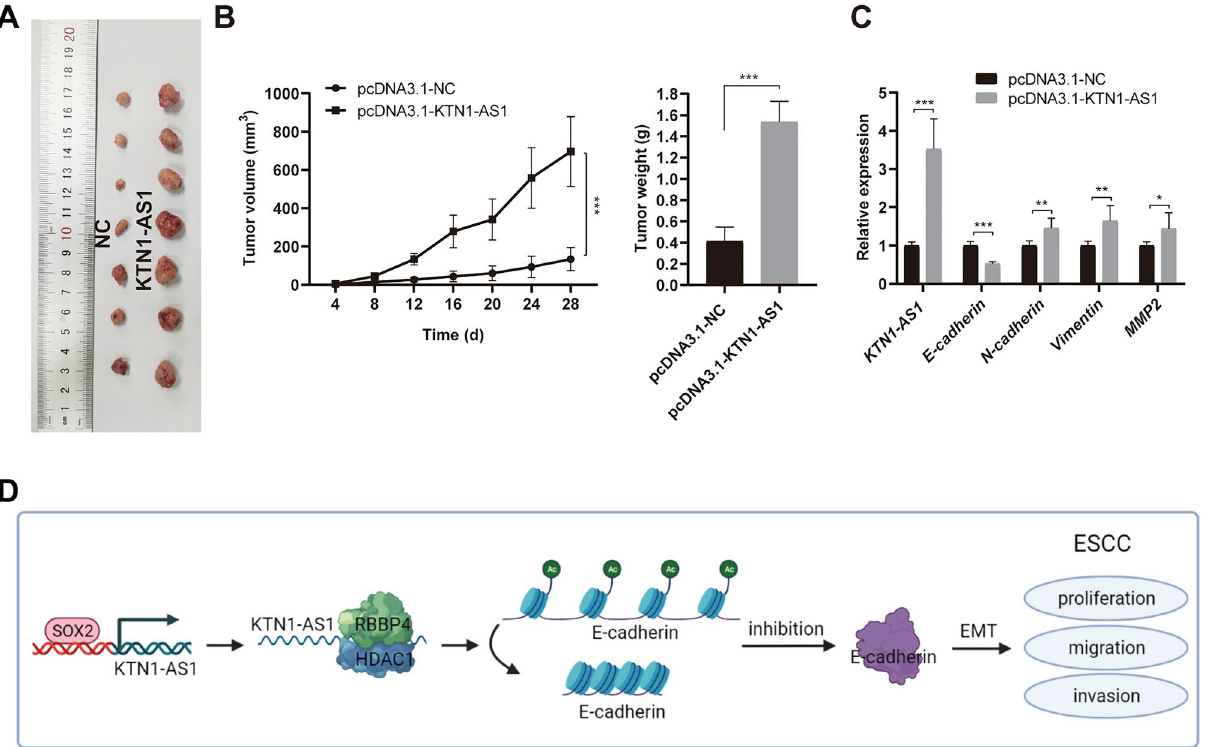
Figure 7. KTN1-AS1 promotes esophageal squamous cell carcinoma (ESCC) cell growth in vivo. ( A ) Xenograft tumor images dissected from nude mice after stable overexpression of KTN1-AS1 . ( B ) The tumor volume and weight of different groups (n = 7). ( C ) The relative expression of KTN1-AS1 , E-cadherin , N-cadherin , Vimentin , and MMP2 in xenograft tissues detected by qRT-PCR method. ( D ) The possible mechanism of KTN1-AS1 regulates ESCC progression. Error bars are shown as mean ± SD from three replicate experiments (n = 3) (* P < 0.05, ** P < 0.01, *** P <